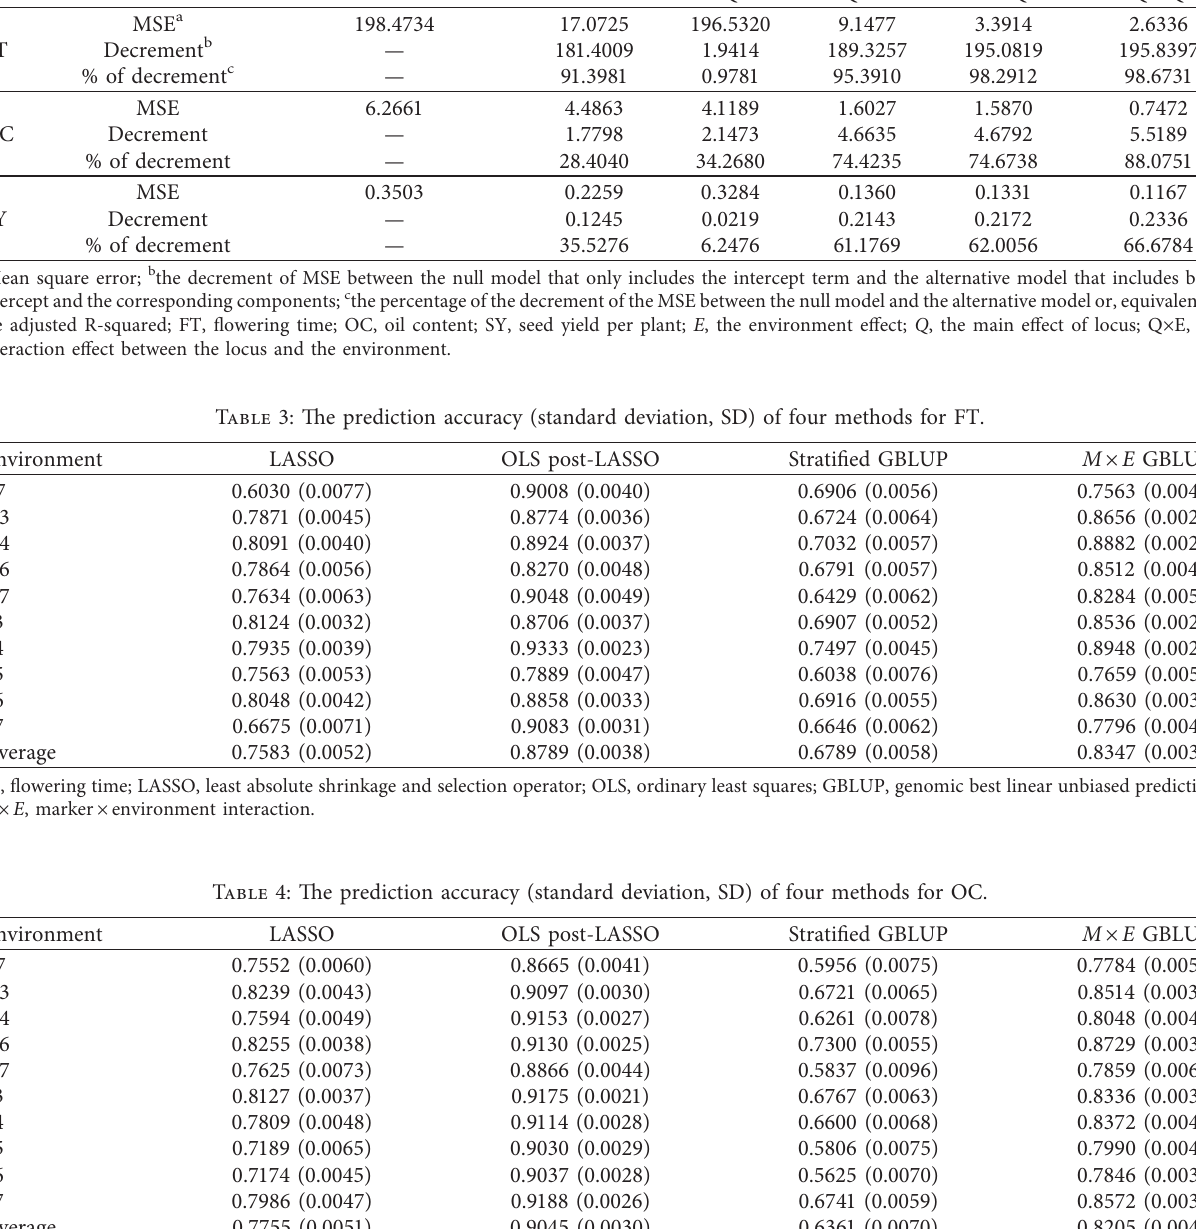
Table 2: The decrement and its percentages of the MSE between the null model and the alternative model. Trait